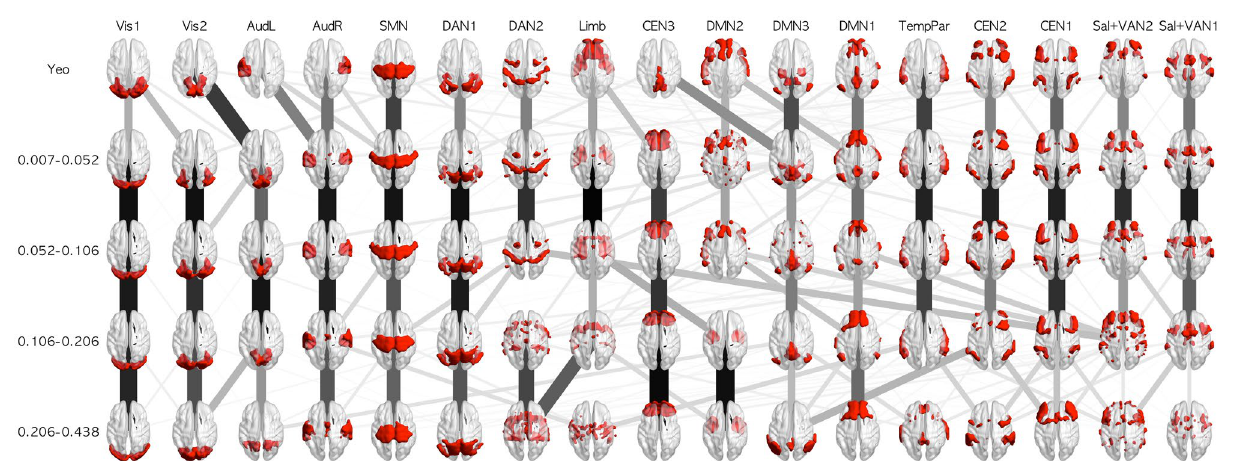
Figure 3. Seventeen RSNs from the data of Yeo et al. 5 and each frequency band. The line width and color reflect the overlap ratio between networks. This figure was created using Matlab 2017a (Mathworks, USA) with BrainNet Viewer 1.7 58 and python 3.6.0 with scikit-image 0.19.3, Pillow 9.4.0, and matplotlib